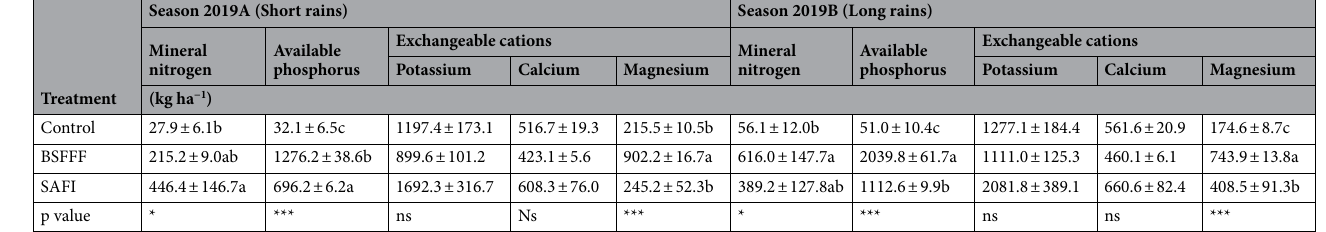
Table 4. Nutrients released from unamended soil and soils amended with organic fertilizers during the short and long rains cropping seasons. ***p < 0.001, **p < 0.01, *p < 0.05, ns = nonsignificant at p ≥ 0.05, BSFFF = Black soldier fly frass fertilizer, SAFI = commercial organic fertilizer, control = unamended soil. Within the same column and per parameter, means (± standard error) followed by the same letters are not significantly different at p ≥ 0.05, n =